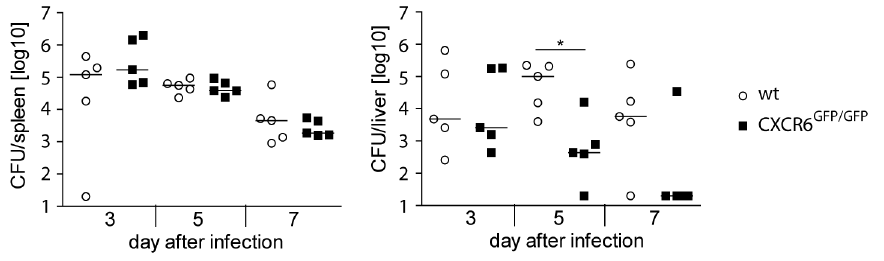
Figure 2. Control of L.monocytogenes in CXCR6-deficient mice. Wt and CXCR6 GFP/GFP mice were infected with 1 6 10 4 Lm i.v. and listeria titers in spleens and livers were determined at indicated time points. Colony forming units (CFU) for individual mice and the median of one representative experiment of two are shown, n=5. Detection limit was 20 CFU. *, p , 0.05.